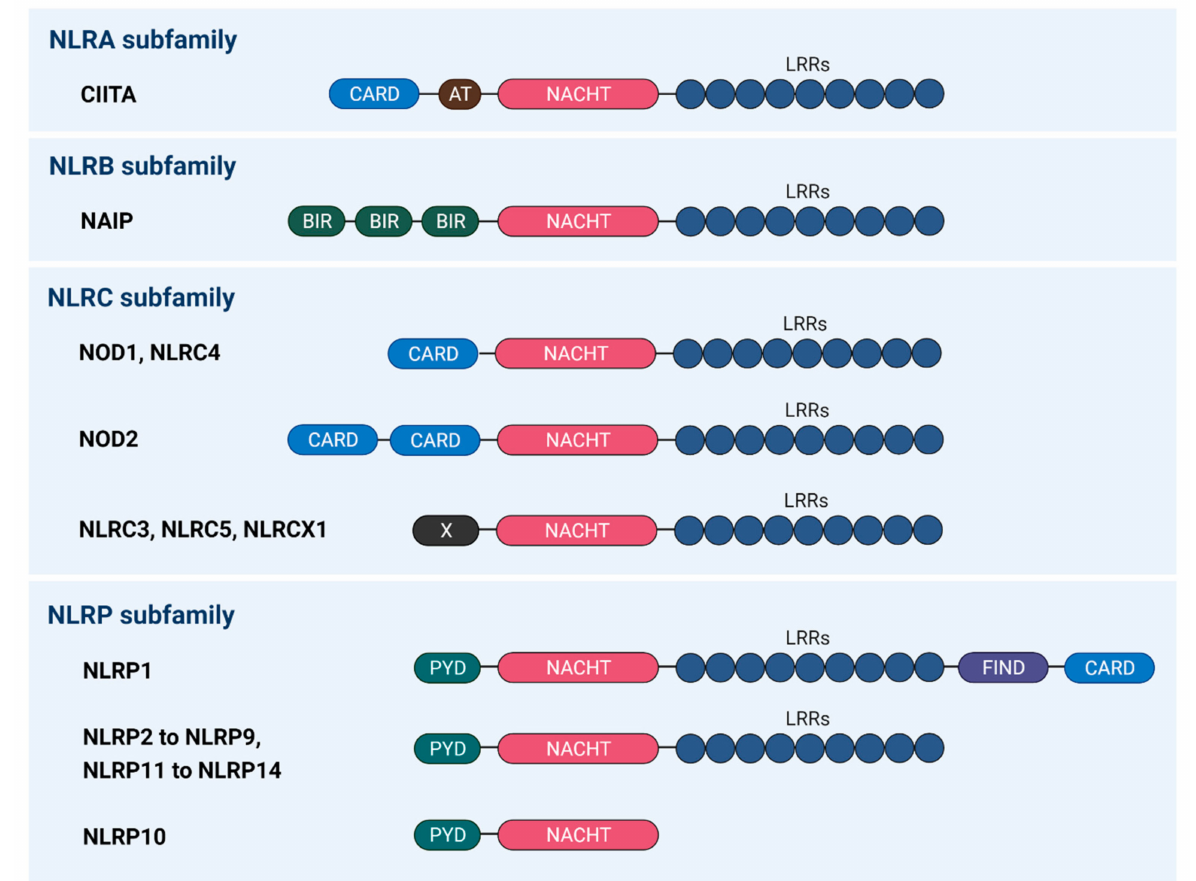
Figure 1. Human NLR subfamilies and their members. The canonical structure of the NLR consists of a tripartite structure, including a N-terminal domain, a central NACHT domain, and C-terminal LRRs. A total of 22 human NLRs have been identified to date and they can be classified into four subfamilies based on their N-terminal effector domains. NLRA subfamily consists of one NLR member–CIITA, which possesses AT at its N-terminal region, while NLRB subfamily comprises NAIP that have BIR domains. NLRC subfamily members are characterised with the presence of CARD domain; NLRP subfamily members are PYD-containing NLRs and they are well-known for the regulation of NF- κ B pathway to modulate the release of pro-inflammatory cytokines through the formation of the oligomeric inflammatory complex termed the “inflammasome”. (NLR, NOD-like receptor; NACHT, also known as NOD (nucleotide binding and oligomerisation domain); LRRs, leucine-rich repeats; AT, acidic transactivation domain; PYD, pyrin domain; CARD, caspase activation and recruitment domain; BIR, baculoviral inhibition of apoptosis protein repeat; NF- κ B, nuclear factor kappa B; FIND, function-to-find domain; X,